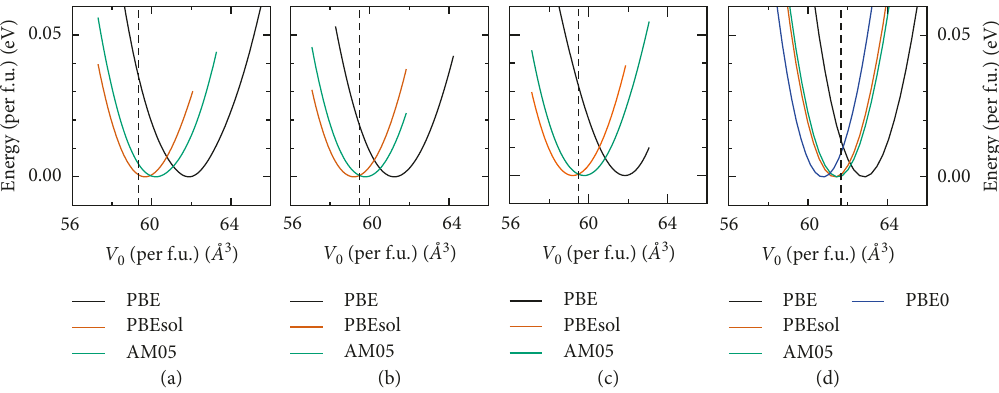
Figure 2: NaNbO 3 total energy curves calculated with different exchange-correlation functionals for (a) the rhombohedral (SG 161), (b) the orthorhombic Pbcm phase (SG 57), (c) the monoclinic Pm phase (SG 6), and (d) the simple cubic perovskite Pm 3 m phase (SG 221). Exchange-correlation functionals include the conventional PBE functional of Perdew et al. [16], the PBEsol functional revised for solids [18], the AM05 functional [17], and the PBE0 hybrid functional [19]. Zero energy has been rescaled corresponding to the lowest energy for each functional. The vertical black dashed lines correspond to the experimental ground state volumes.